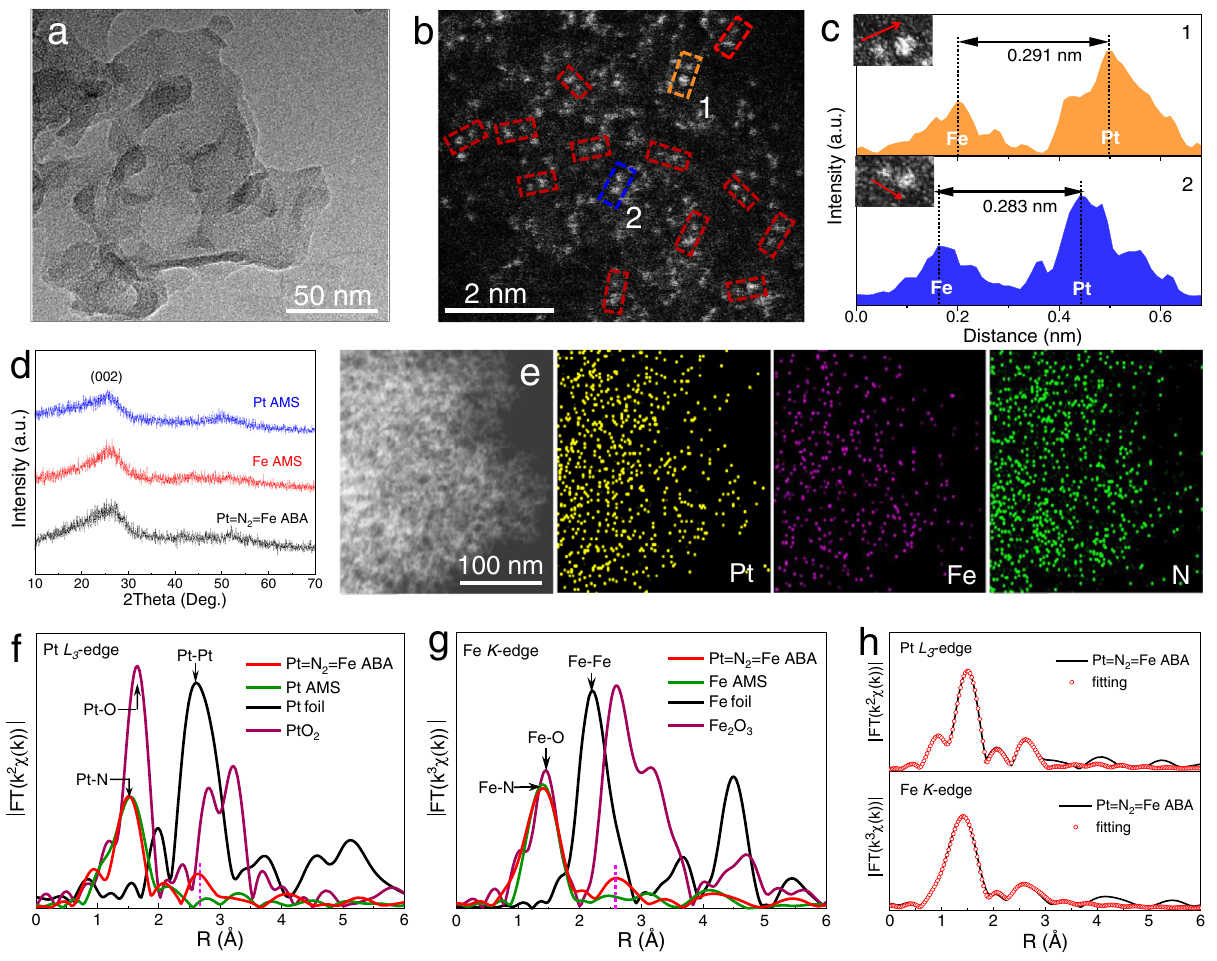
Fig. 1 | Morphology and structural characterizations. a , b TEM ( a ) and HAADF- STEM( b )imagesofthePt=N 2 =FeABAcatalyst. c Intensitypro fi lealongLine1and Line 2 in b. d XRD patterns of Pt=N 2 =Fe ABA, Fe AMS and Pt AMS. e TEM-EDS